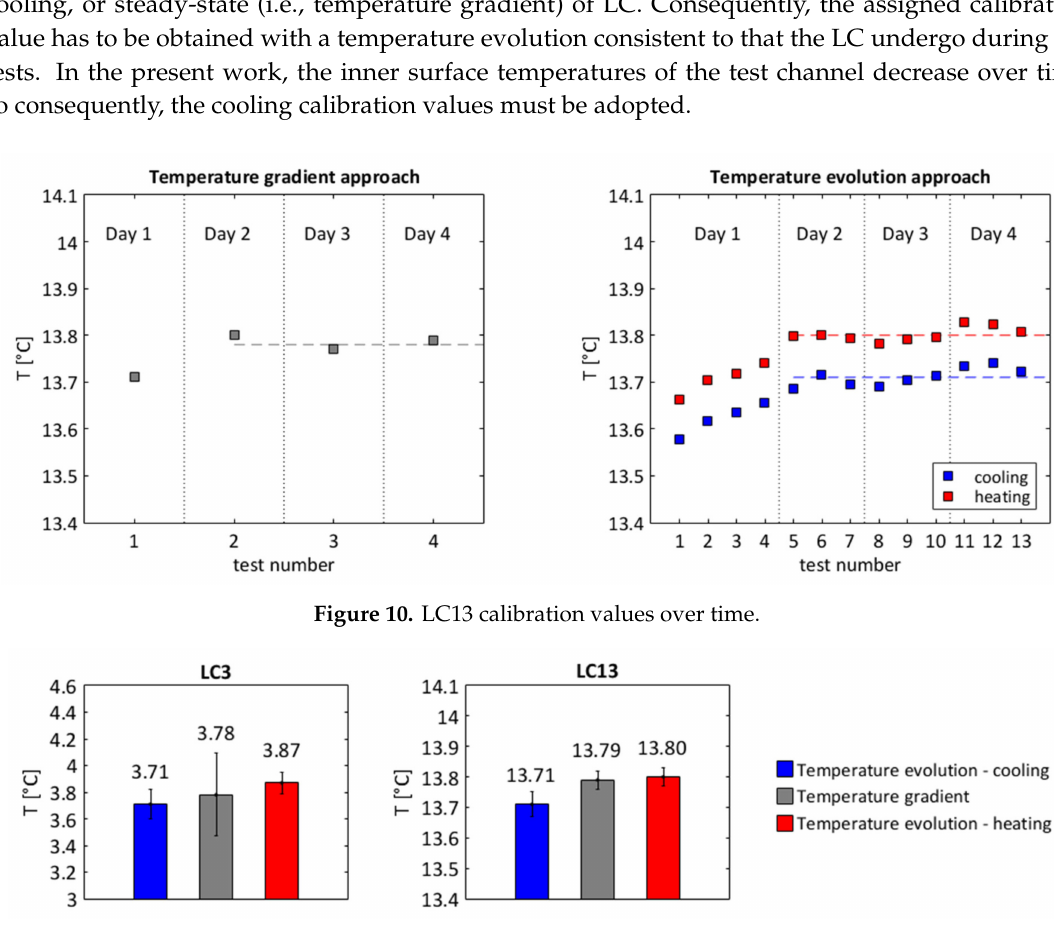
Figure 11. Averaged calibration values for the LC3 and